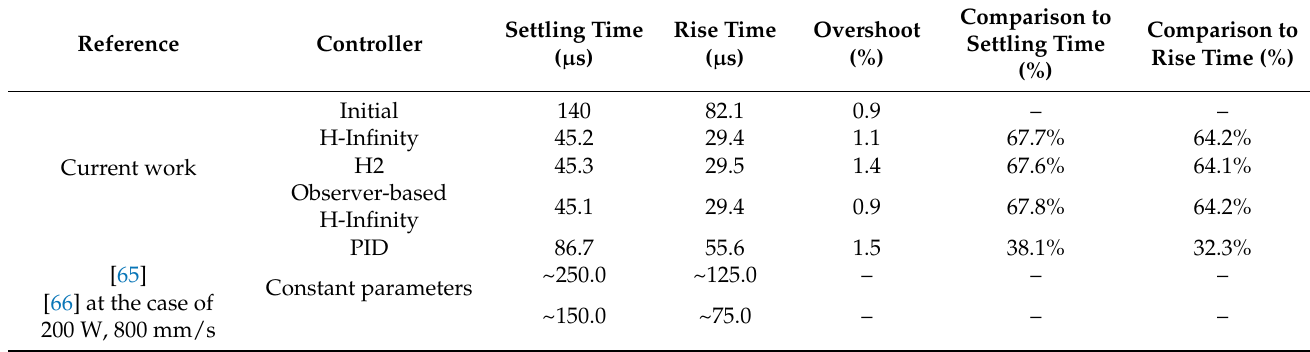
Table 2. Comparison of developed controllers with relevant